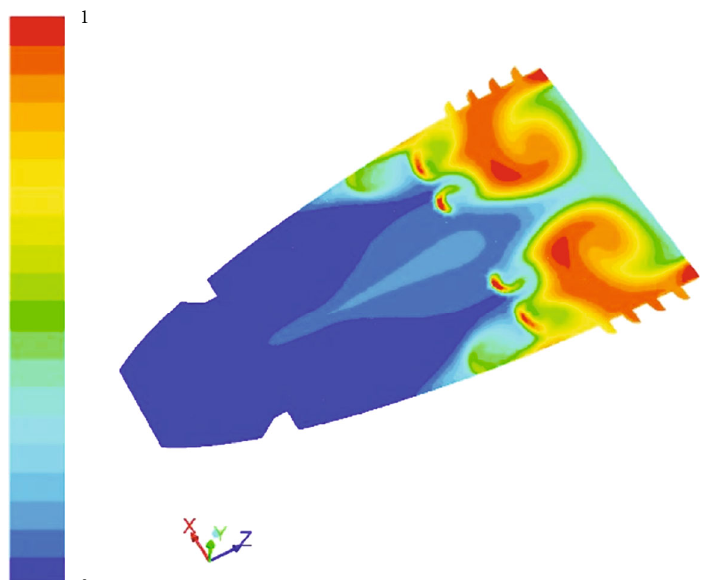
Figure 8: Temperature contours in horizontal plain in axial